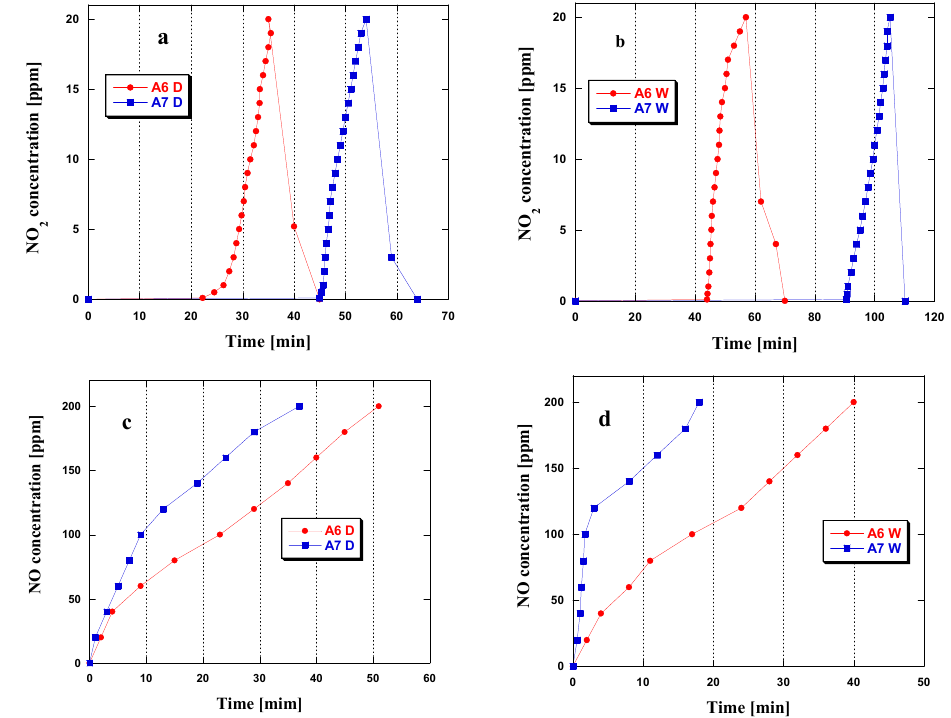
Figure 5. NO 2 and NO breakthrough curves obtained during adsorption in dry ( a , c ) and wet ( b , d ) conditions for the biochars obtained. ( b , d ) conditions for the biochars